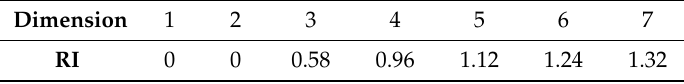
Table 1. Values of RI based on matrix